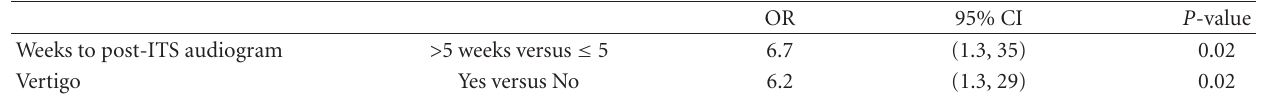
Table 5: Adjusted odds of improvement ( N =